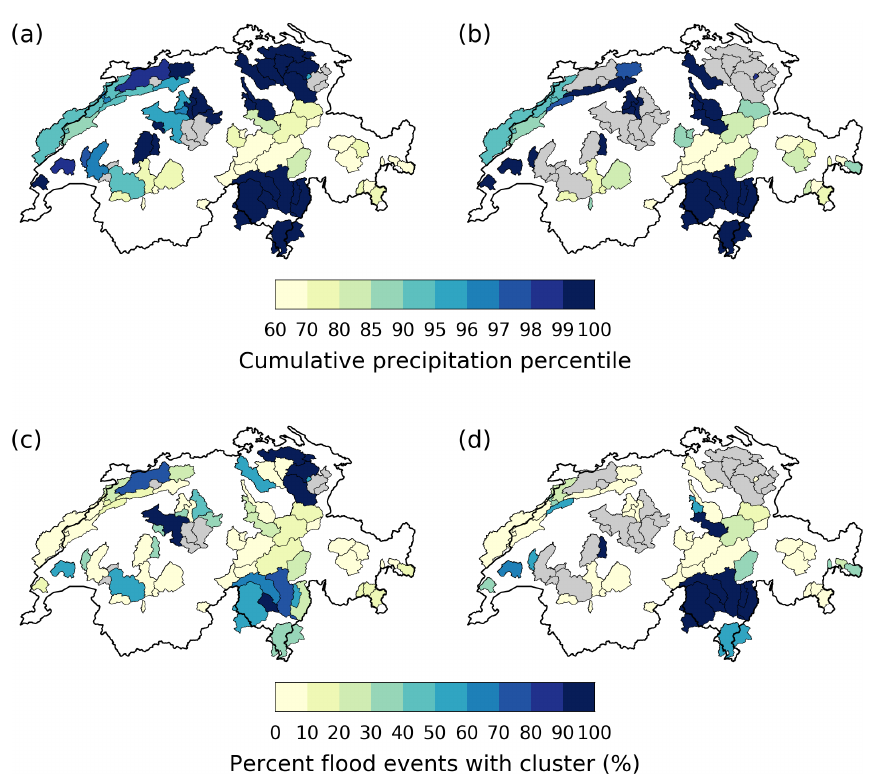
Figure 8. (a, b) Average cumulative precipitation percentile during and 10d prior to persistent high-discharge periods, defined as (a) at least 5d within a 10d window with discharge above its 99th percentile and (b) at least 8d within a 20d window with discharge above its 99th percentile. Catchments for which such persistent high-discharge periods are not observed are shown in gray. (c, d) Same as (a, b) , but for the frequency of cluster occurrence during and 10d prior to persistent high-discharge periods.